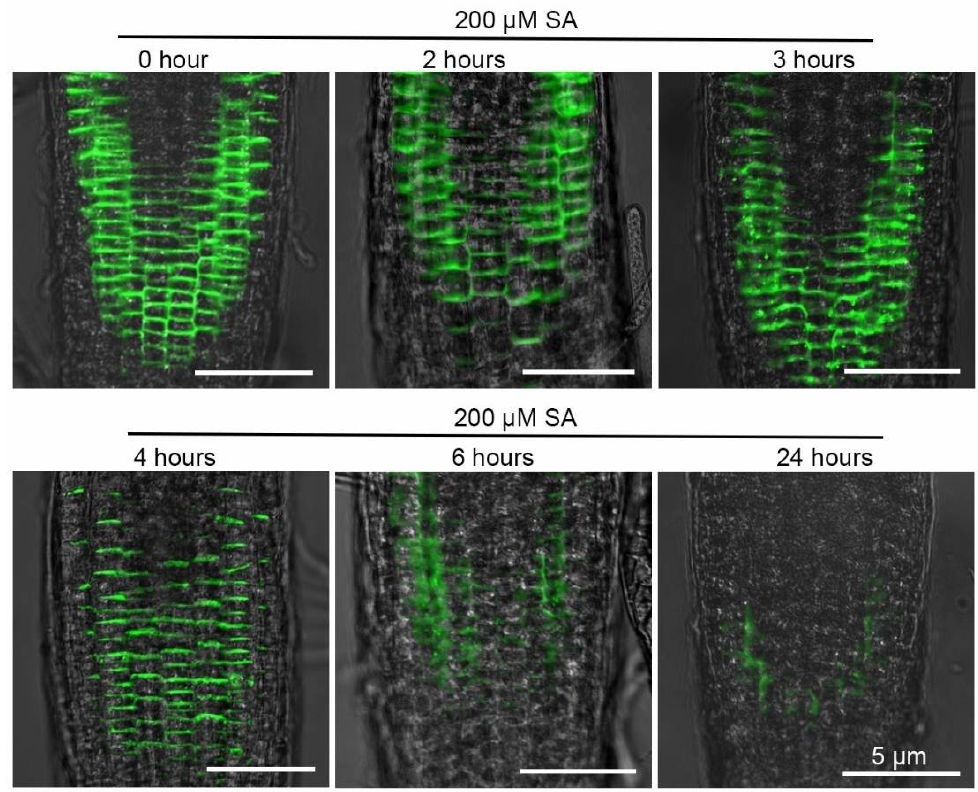
Figure 4. High-concentration SA induces PIN2-GFP degradation. PIN2-GFP fluorescence signal in the roots of five-day-old ProPIN2: PIN2-GFP transgenic seedlings treated with 200 µ M SA for 0, 2, 3, 4, 6 and 24 h was observed. Scale bar = 5 µm.